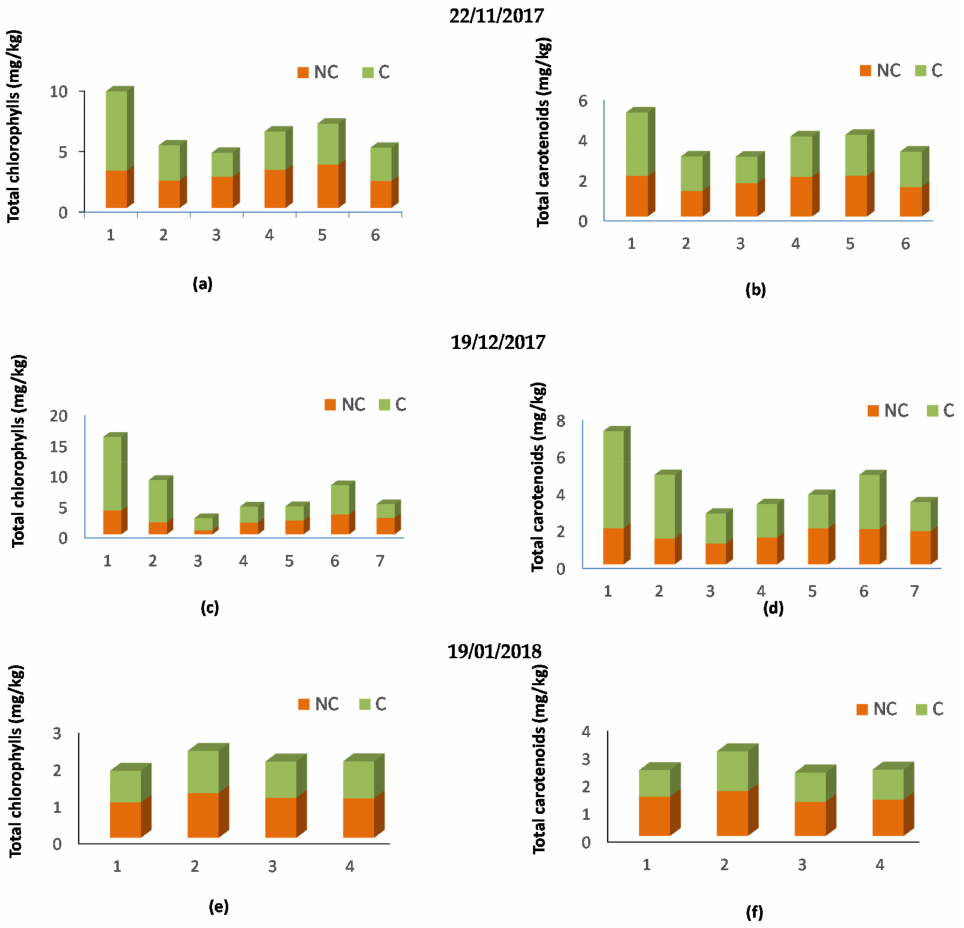
Figure 1. Pigment content variation according to vertical centrifugation and collecting period. ( a ) chlorophyll content variation in olive oils of 22 / 11 / 2017; ( b ) carotenoid content variation in olive oils collected at 22 / 11 / 2017; ( c ) chlorophyll content variation in olive oils at 19 / 12 / 2017; ( d ) carotenoid content variation in olive oils of 19 / 12 / 2017; ( e ) carotenoid content variation in olive oils collected at 19 / 01 / 2018; and ( f ) carotenoid content variation in olive oils of 19 / 01 / 2018. NC: Before vertical centrifugation, C: After vertical